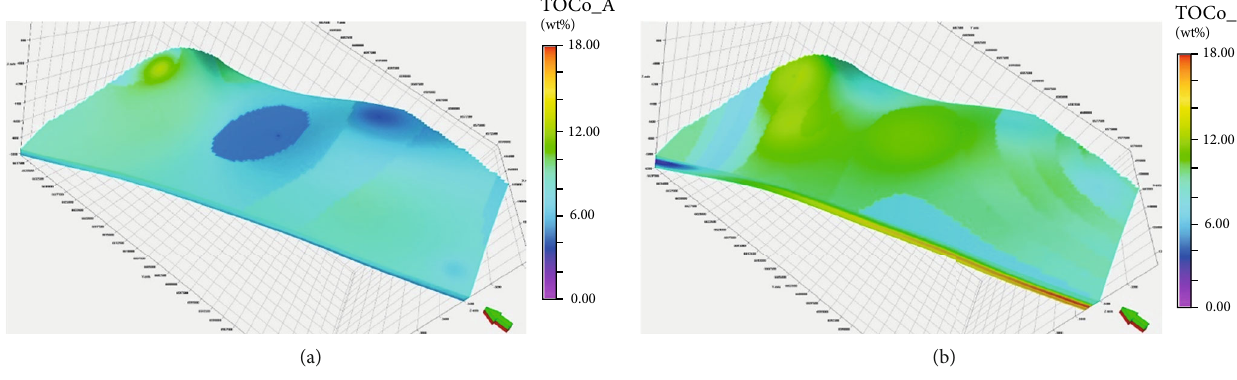
Figure 11: 3D distribution of TOCo of the A shale bed (a) and the B shale bed (b) in the study area ( × 20 vertical exaggeration). Relatively high TOCo distribution in the A bed is shown at the upper layer and northwestern region and in the B bed is shown at the lower layer and southern region.